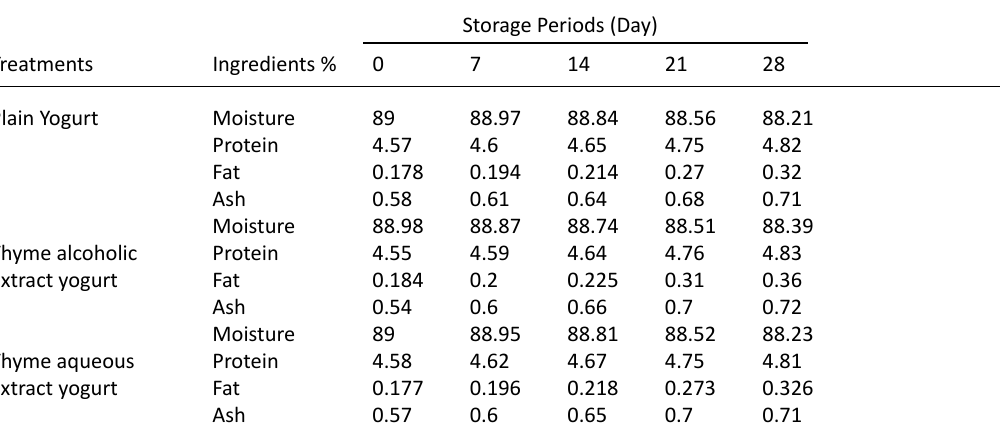
Table 1. Chemical compositions of plain yogurt, thyme alcoholic extract yogurt and thyme aqueous extract yogurt Storage Periods (Day) Treatments Ingredients % 0 Plain Yogurt Moisture